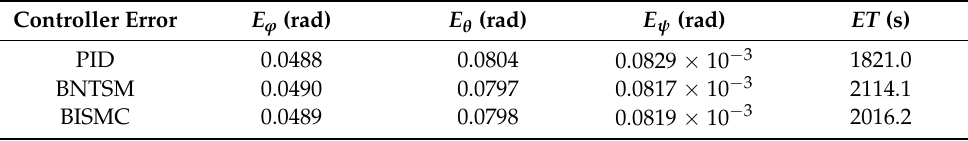
Figure 9. Tracking responses of Euler angles with and without fault compensation.